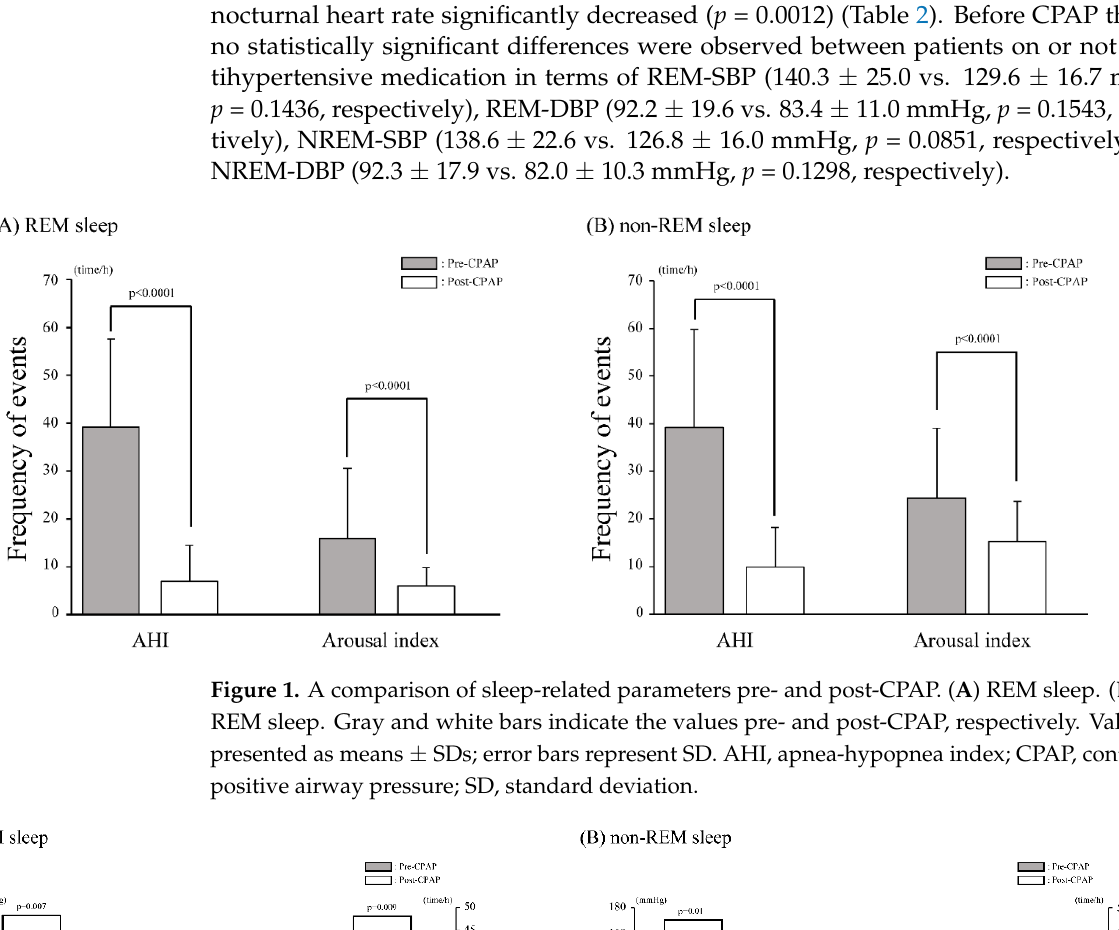
Table 2. Changes in nocturnal BP fluctuations, BP, and heart rate.